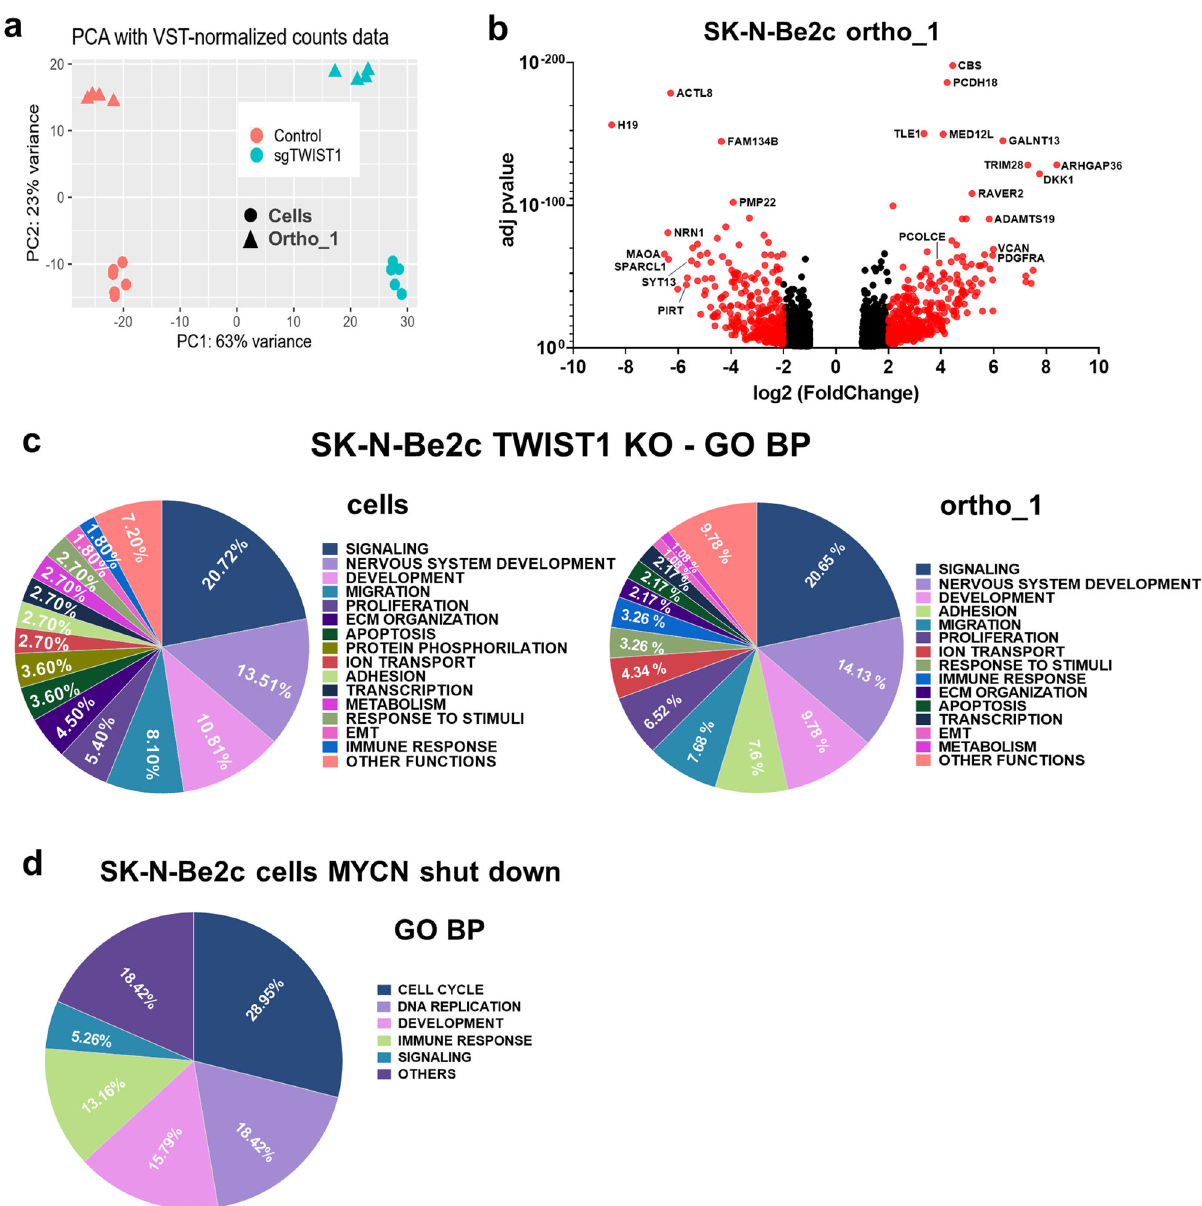
Fig. 4 The biological pathways deregulated by TWIST1 KO are distinct from those mediated by MYCN shut down. a PCA samples repartition using the VST-normalized counts. PCA1 and PCA2 are 63% and 23% of total variation, respectively. b Volcano plots showing the distribution of the DE genes according to FC (log2) and adj p value between the SK-N-Be2c-Control and – sgTWIST1 ortho_1-derived xenografts. Genes with False Discovery Rate (FDR) < 0.05 and absolute value (av) of log2(FC) ≥ 1 were considered as DE; in red genes with av of log2(FC) ≥ 2, in black genes with av of log2(FC) ≥ 1 and <2. Positive and negative x -values represent genes either up- or downregulated by TWIST1, respectively. c Illustration of the biological processes gene sets found enriched by GO analyses (GO BP) in the DE genes following TWIST1 KO for both SK-N-Be2c cells (left panel) and ortho_1 tumors (right panel). Data are reported as the repartition (in %) of the diverse pathways identi fi ed with a FDR < 0.01 ( n = 111 for cells, n = 92 for tumors). d Illustration of the GO BP gene sets found enriched in the DE genes in SK-N-Be2c cells upon JQ1-mediated MYCN shutdown. RNAseq data of SK-N-Be2c cells treated with JQ1 during 24 h or DMSO as control were uploaded (GSE80154, see “ Methods ” ) 17 . Genes with False Discovery Rate (FDR) < 0.05 and absolute value (av) of log2(FC) ≥ 1 were considered as DE. Data are reported as the repartition (in %) of the diverse pathways identi fi ed with a FDR < 0.01 ( n = study, we show their opposite expression pattern in primary NB TWIST1-associated transcriptional signature, which correlated and their antithetical prognostic value, highlighting that TWIST1 with outcomes in human primary tumors and activated the TME expression was correlated with unfavorable NB prognostic fac- in an orthotopically-derived xenograft murine model. tors, metastasis, disease progression, and poor survival. These TWIST1 and TWIST2 have previously been described as fi ndings are in line with prior studies conducted on non- playing a distinct role during embryonic development and hav- pediatric cancers showing the overexpression of TWIST1 in high ing anti-correlated transcriptional expression patterns in spon- grade and invasive/aggressive breast, bladder, cervical, ovarian, taneous focal mammary tumors in mice and in human and hepatocellular cancers where it might also serve as melanoma, colon, kidney, lung, and breast cancer 30 . In this